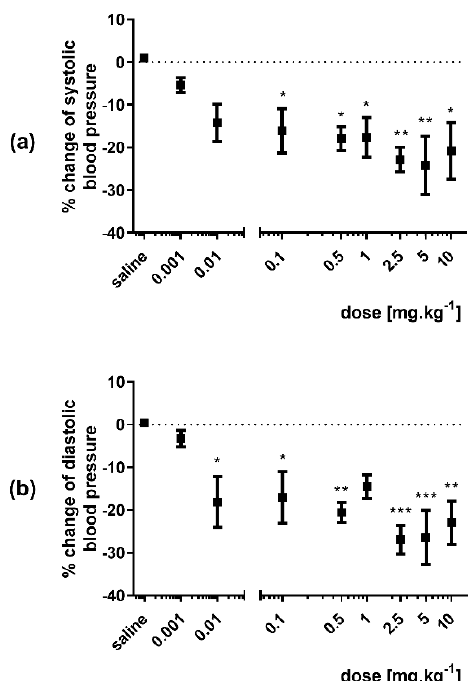
Figure 3. Changes in arterial systolic ( a ) and diastolic ( b ) blood pressures after bolus i.v. administra- tion of 3-hydroxyphenylacetic acid (doses ranging from 0.001 to 10 mg · kg − 1 ) expressed as percent change from the initial value in spontaneously hypertensive rats ( n = 8). Significant change: * p < 0.05, ** p < 0.01, *** p < 0.001 vs. saline.